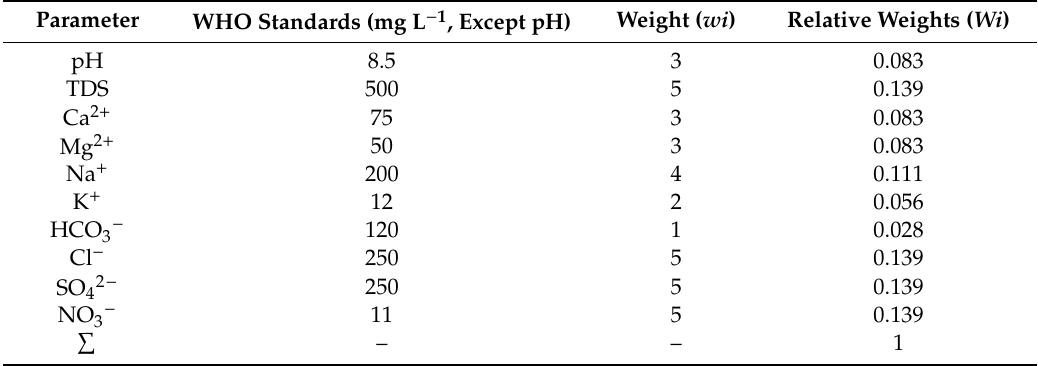
Table 1. The weight ( wi ) and relative weight ( Wi ) of each chemical parameter calculated based on the standard values reported by the World Health Organization (WHO,